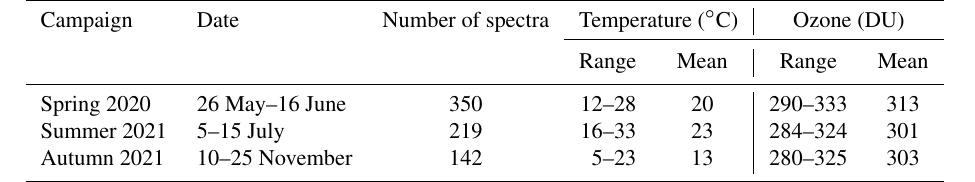
Table 1. Summary of ambient temperature, ozone and number of cloud-free spectra registered during the three measurement campaigns. Campaign